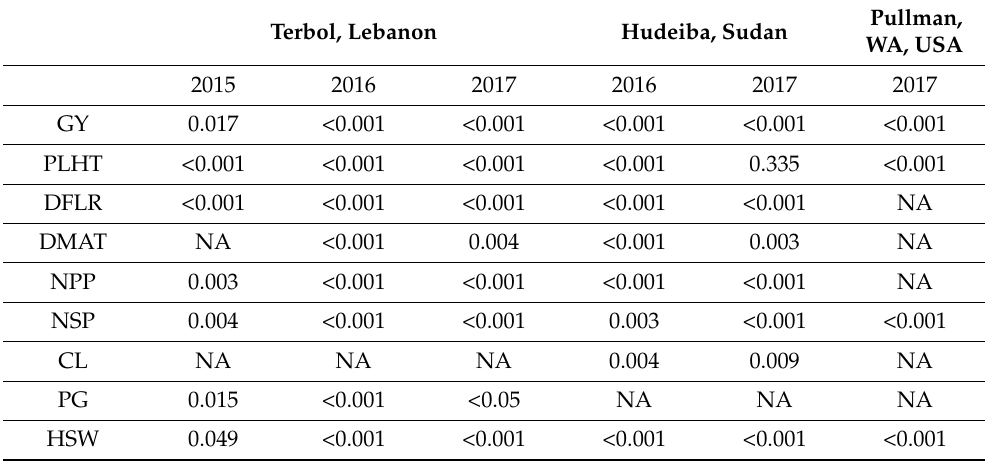
Table 1. Spatial model analysis performed for detecting significance differences in genotypic variation of phenotypic and physiologic traits, expressed as p -value.